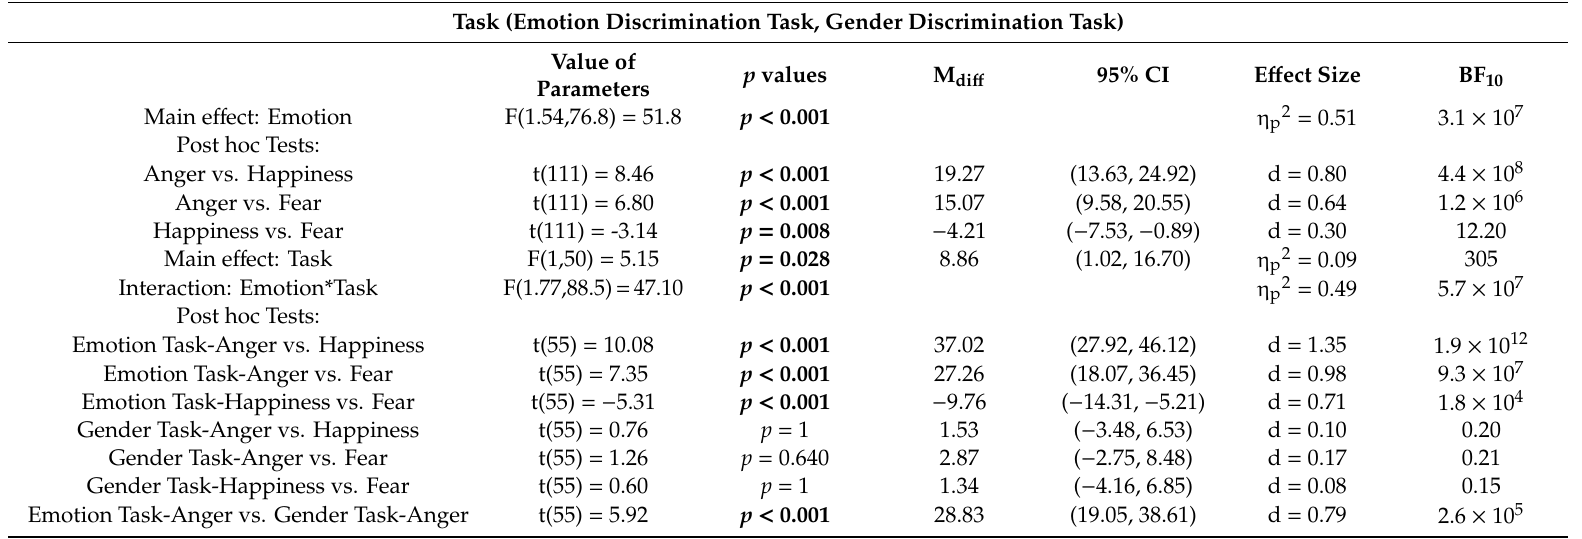
Table 2. Results of the statistical analysis on reaction times (RTs). Post hoc tests (pairwise comparisons) had an adjusted alpha level corrected according to Bonferroni. Statistically significant results are reported in bold. Bayes factors report the ratio of likelihood of the alternative hypothesis to the likelihood of the null hypothesis (BF 10 ). ANOVA, analysis of variance. Measures of size e ff ects: η p2 for ANOVAs and Cohen’s d for post hoc tests. Di ff erences in the estimated marginal means (M di ff ) are reported along with their 95% confidence interval